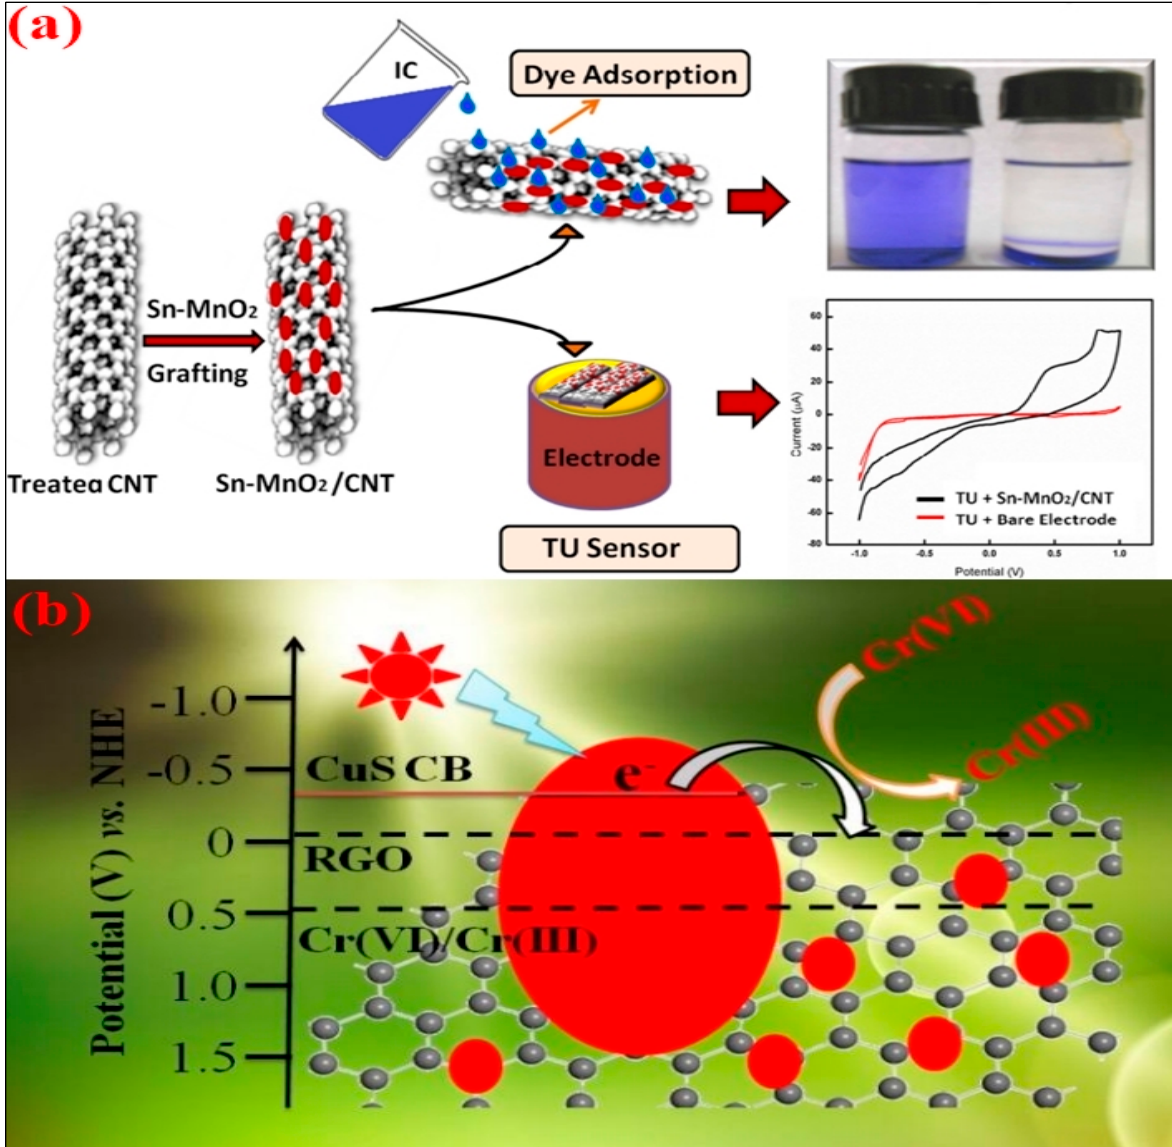
Figure 8. ( a ) Fabricated Sn doped MnO 2 /CNT NM utilized for elimination of dyes via adsorption and also for electro-chemical sensing of thiourea (Reprinted with permission from [152] Elsevier, License No. 5399130850139), ( b ) photocatalytic mechanism of CuS/RGO for chromium photo-reduction (Reprinted with permission from [153] Elsevier, License No.